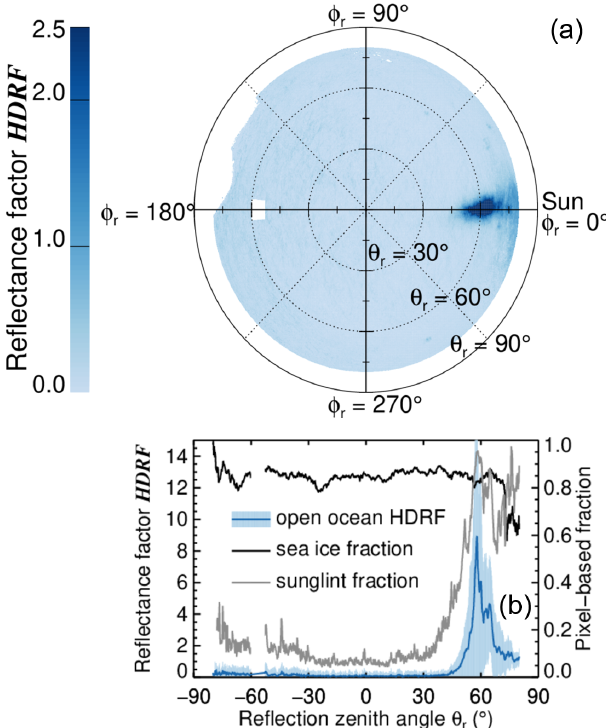
Figure 6. (a) Polar plot of the separated mean HDRF of open ocean. (b) Cross-section of the HDRF of open ocean along the solar prin- cipal plane (blue). The shaded area shows the standard deviation calculated for each direction of the solar principal plane from the entire time series (138 images). The black line denotes the mean pixel-based sea ice fraction (the portion of images where the re- spective pixel of the solar principal plane is assigned to sea ice). The grey line denotes the mean pixel-based sunglint fraction (the ratio of the number of images where the respective pixel of the so- lar principal plane is classified as sunglint to the number of images where this pixel is assigned to open